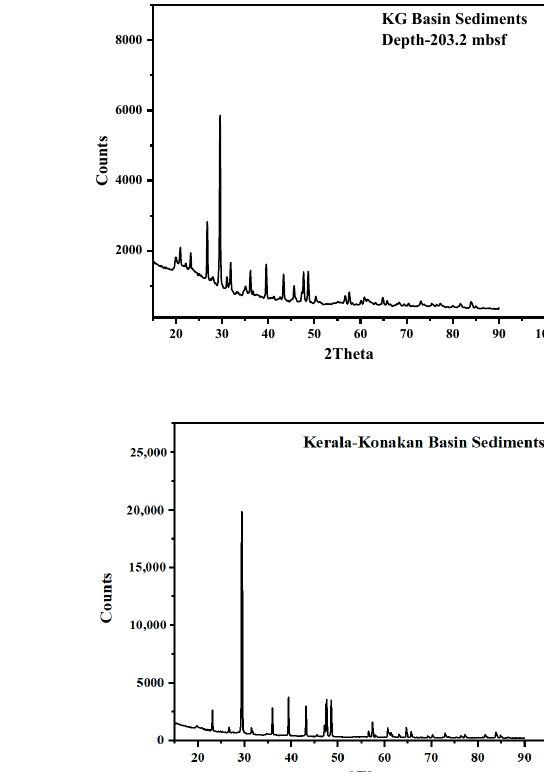
Figure 4. XRD Diffractogram.